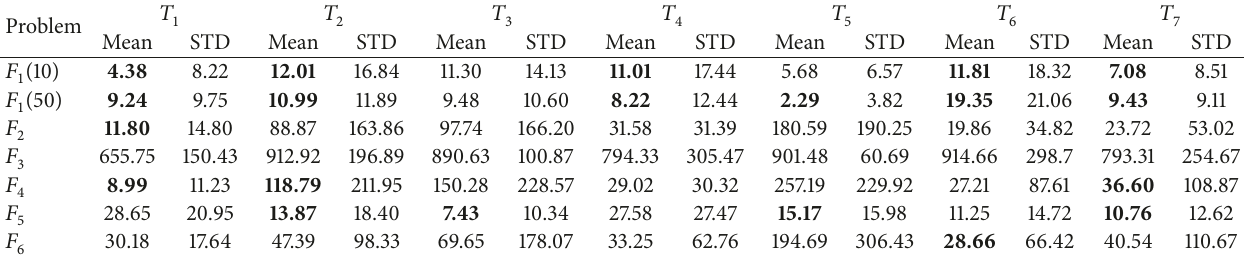
Table 7: Mean error values achieved for problems 𝐹 1 – 𝐹 6 by Shrinking-based BA.